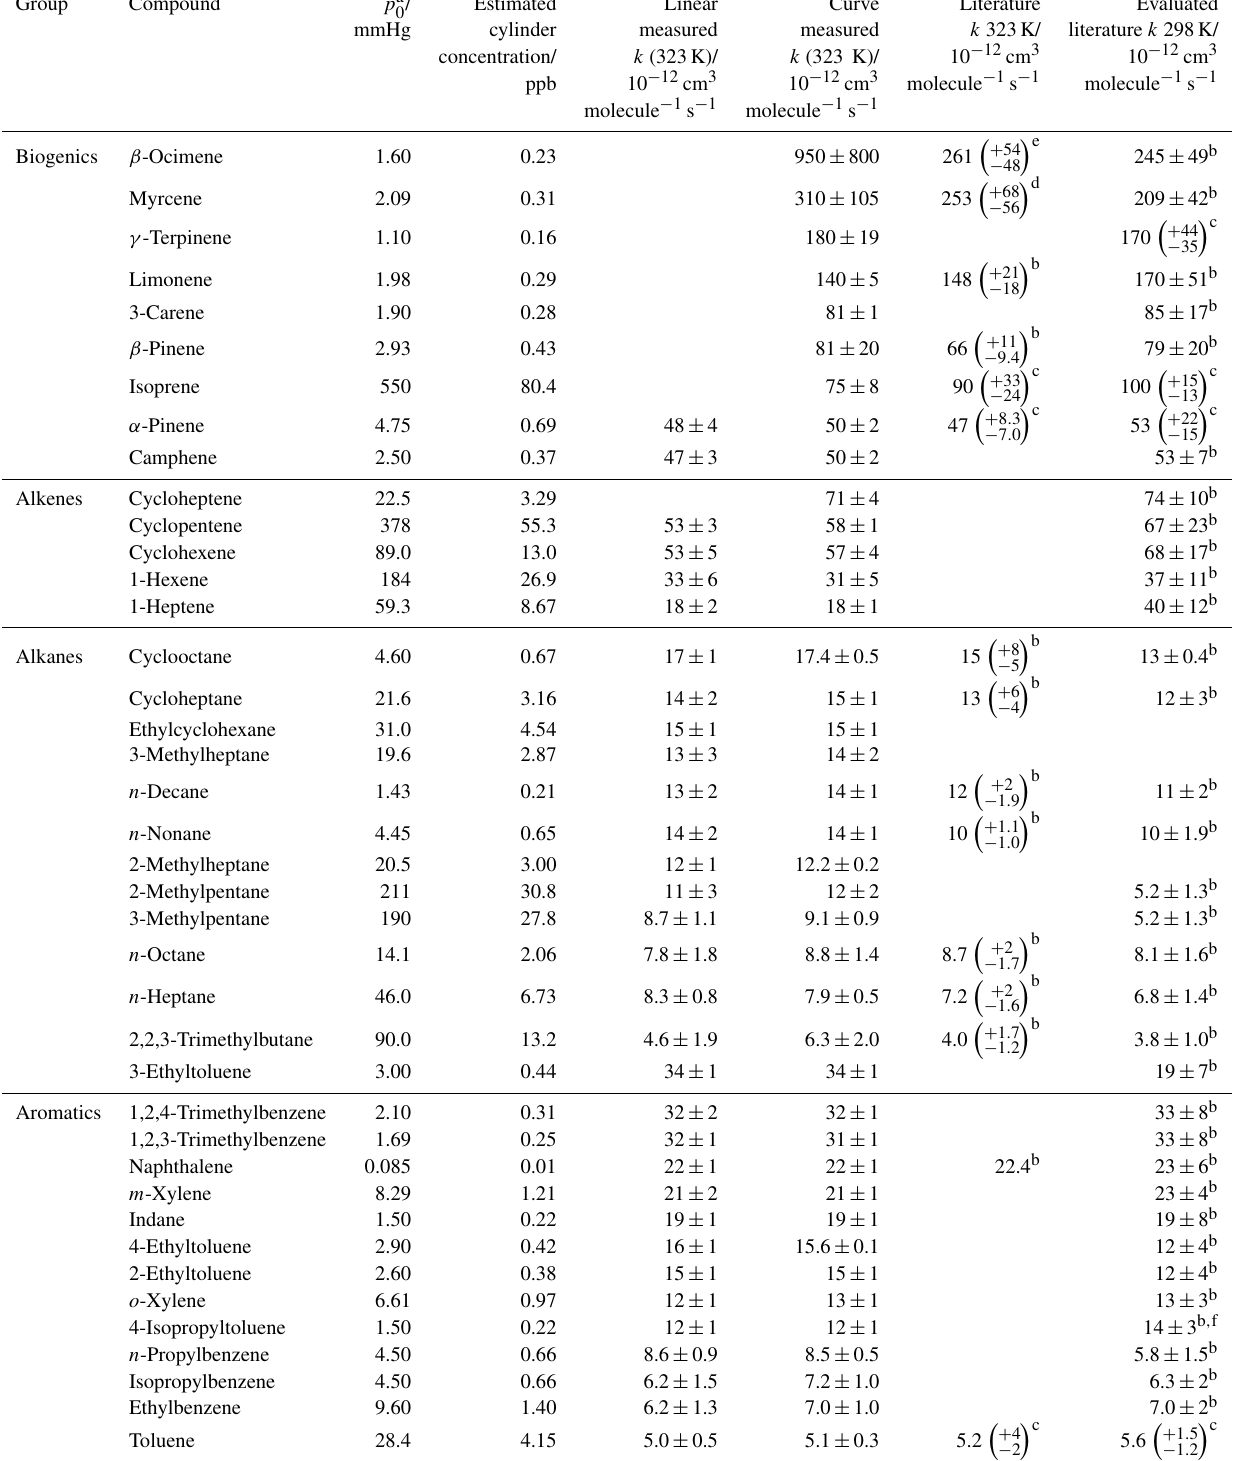
Table 3. Results of relative rate experiments, with literature data, for each VOC in Mixture 3, ordered by curve measured k value. Group Compound p a / Estimated Linear Curve 0